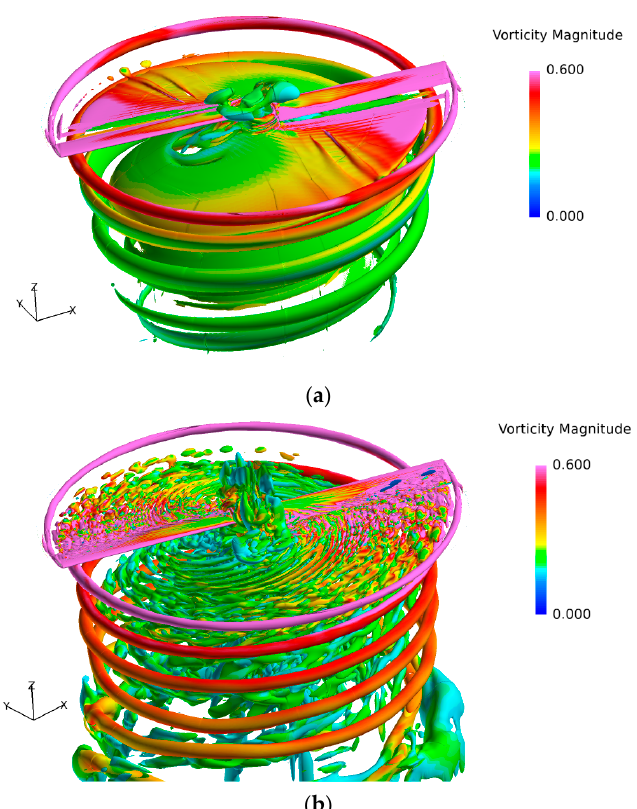
Figure 15. Comparison of blade tip vortices distribution in Q-criterion obtained by RANS and DDES.(Q = 10.0). ( a ) RANS, ( b ) DDES.